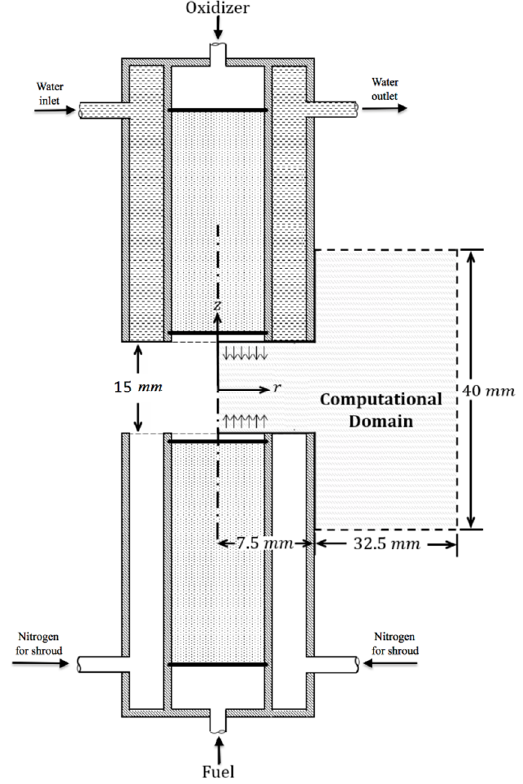
Figure 1. Schematic diagram of the non-premixed crossflow burner and the considered computa- tional domain.